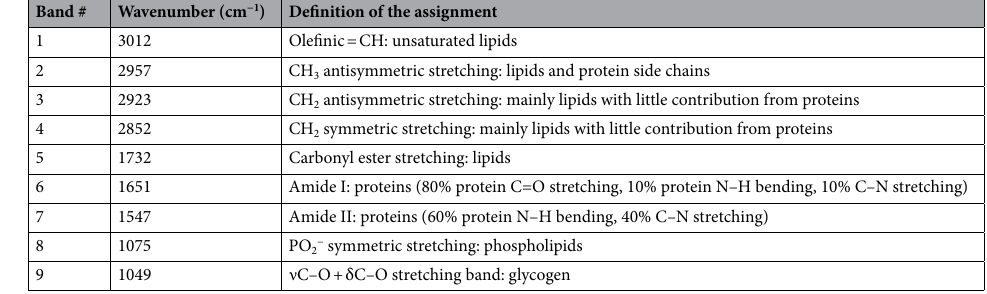
Table 1. The assignments of the bands used in the analysis of the spectra of rat hippocampal brain tissue in 3100–1000 cm −1 wavenumber region (Cakmak et al. 2012; 2016, Demir et al., 2015; Ali et al.,